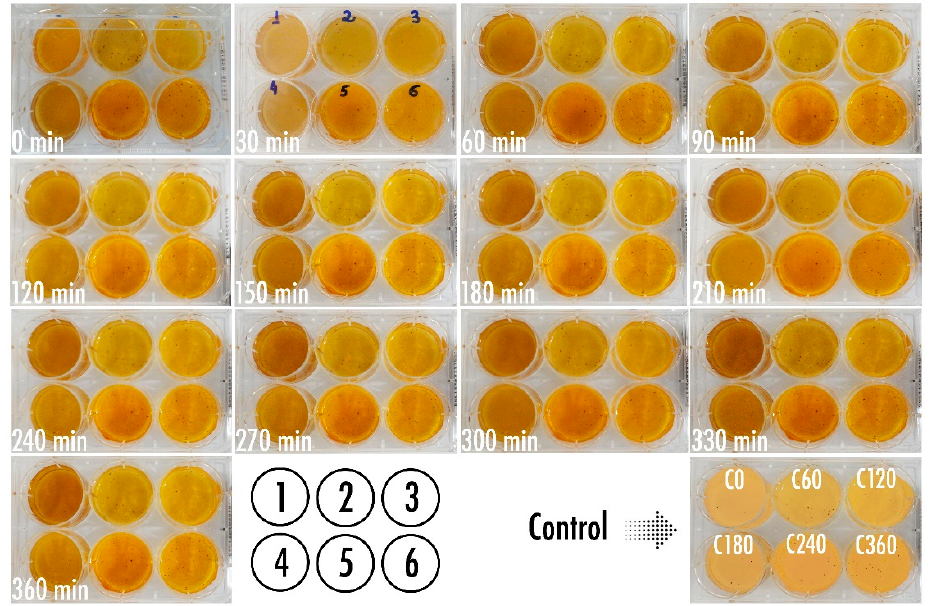
Figure 9. Results obtained using the selected bio-reactive chromogel with optimized concentrations of phage particles, sodium 1,2-naftoquinone-4-sulfonate, gelatin, and casein, in bio-detection system II, with evolution throughout the time of the color produced using variable added amounts of P. aeruginosa cells. As a control for the colorimetric bioreaction, cells of S. aureus CCCD-S009 were also contacted with the selected bio-reactive chromogel (Figure 9, bottom right). Using the same image processing software ImageJ (Fiji, vs. 2.0.0-rc-68/1.52e), the sur- face area of each chromogel was again analyzed pertaining to its integrated color density, and the results were duly normalized by the integrated color density of the chromogels immediately after addition of the bacterial suspension (Figure 10).